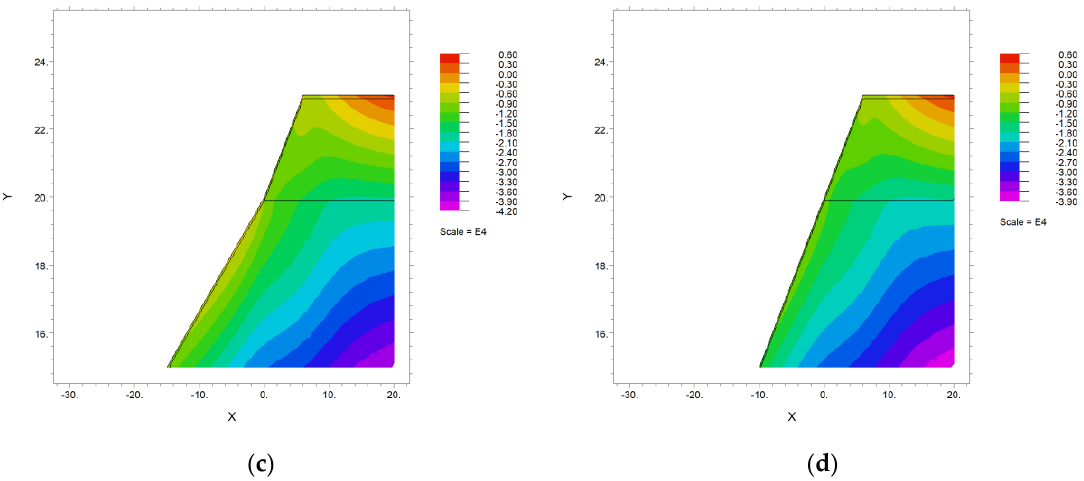
Figure 10. Horizontal stresses for the clay-type subsoil, for underwater slope inclinations of ( a ) 1:5, ( b ) 1:4, ( c ) 1:3, ( d ) 1:2 (negative values indicate compressive stresses in Pa, and positive values—tensile stresses in Pa).